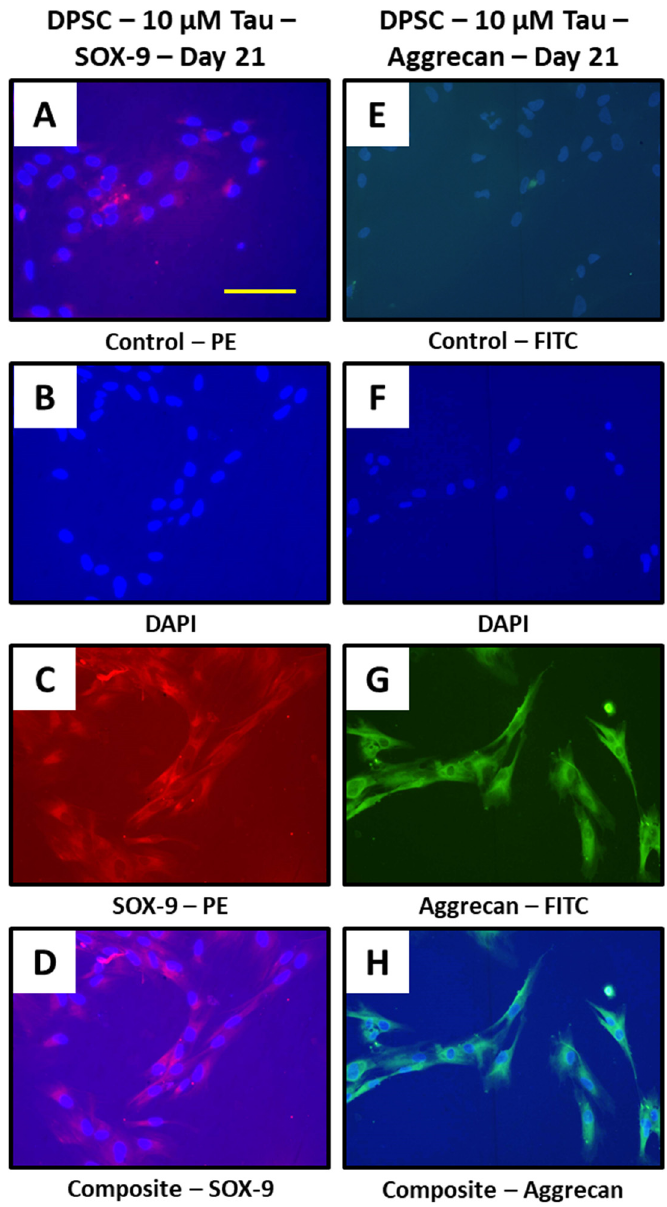
Figure 6. Taurine treatment to DPSCs and immunostaining. ( A – H ) DPSCs treated with taurine alone were assessed for chondrogenesis related proteins SOX-9 and aggrecan at day 21. Scale bar = 200 µ m. Tau: taurine.